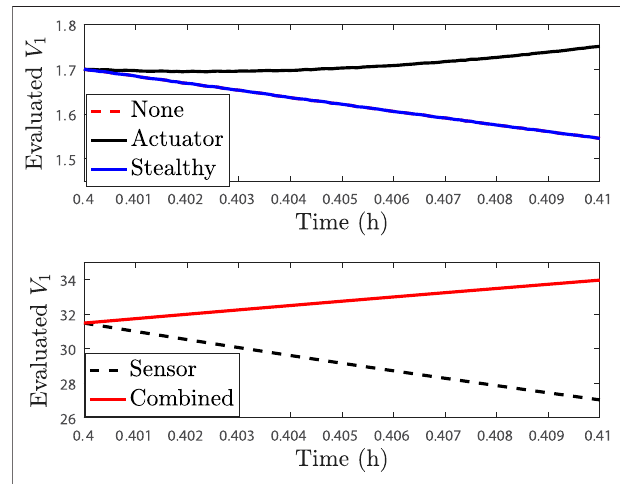
FIGURE2| V 1 pro fi lesevaluatedusingthestatemeasurementsoverone sampling period after 0.4 h of operation for the process example described above in the presence of no attacks ( “ None ” ), only actuator cyberattacks ( “ Actuator ” ), only sensor attacks ( “ Sensor ” ), the baseline combined actuator and sensor attacks ( “ Combined ” ), and the stealthy combined sensor and actuator attack ( “ Stealthy ” ). The plots for no attack and for the stealthy combinedsensorandactuator attackareoverlaidbecausethestealthy attack provides the no-attack sensor trajectory to the detection device to evade